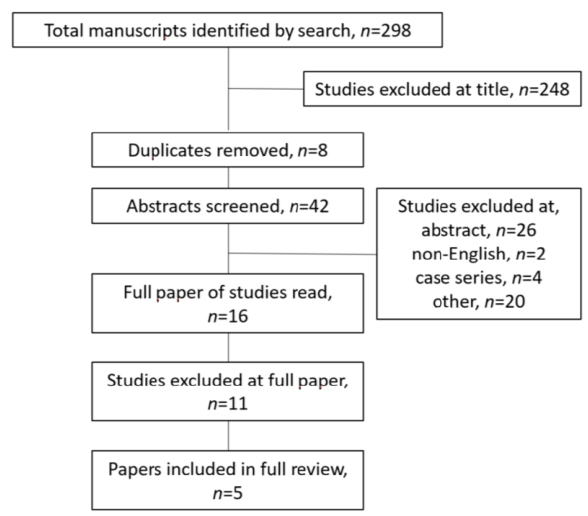
Figure 1. Citation retrieval and handling process.